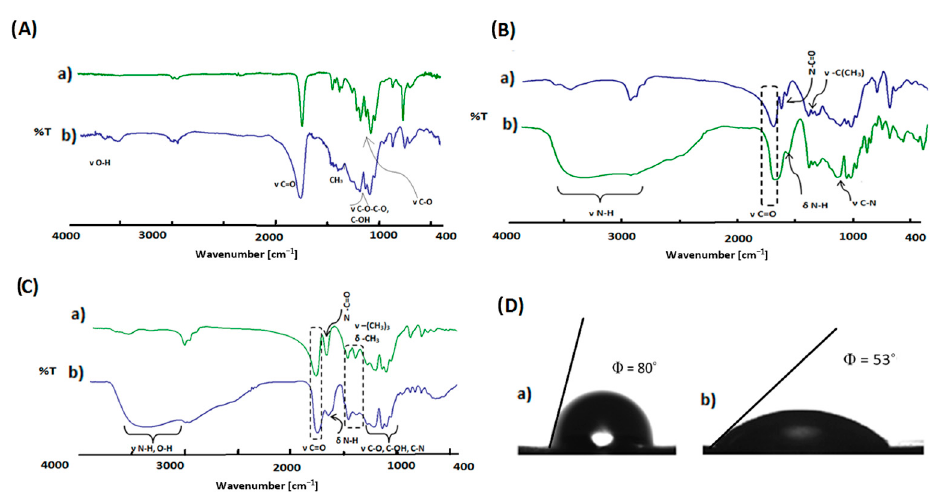
Figure 6. FTIR spectra of terpolymers; ( A ) P1 ( a ) with protected hydroxyl groups ( b ) after deprotection of hydroxyl groups; ( B ) P7 ( a ) with protected amine groups ( b ) after amine group deprotection; ( C ) P4 ( a ) with protected hydroxyl and amino groups ( b ) after deprotection of hydroxyl and amino groups. Photographs of water drop on the surface of P1 ( D ) ( a ) terpolymer foil with protected OH groups; ( b ) terpolymer foil with unprotected OH groups.